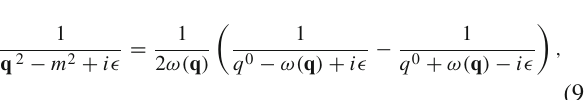
Fig. 2 Feynman diagrams for the p Σ − → K − d reaction. The momenta of the lines are shown in brackets ¯ K , with f = 93 MeV, D = 0 . 795, F = for an incoming 0 . 465 [71]. In